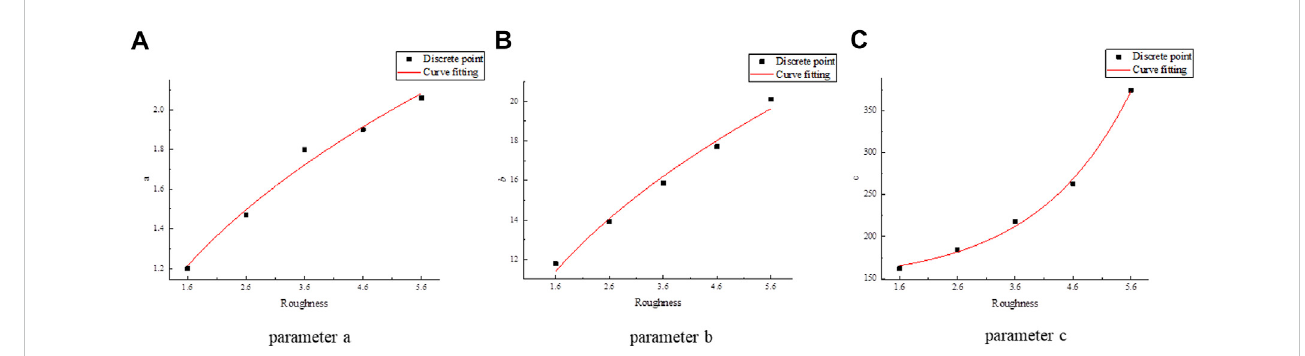
FIGURE 5 Fitting curve of parameters and joint roughness coef fi